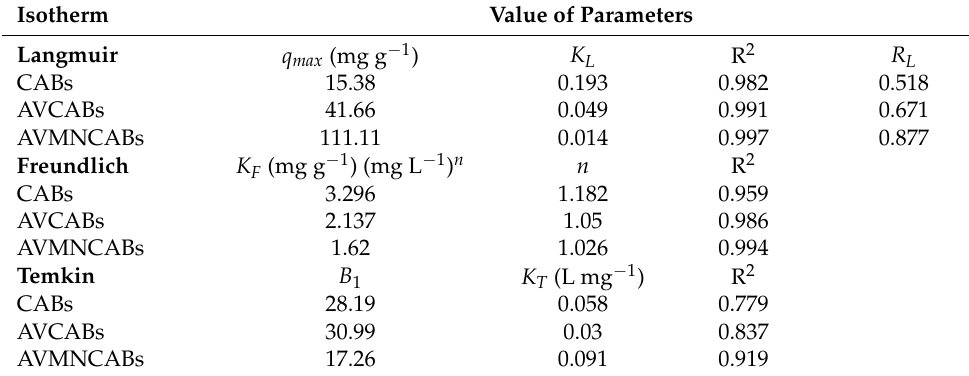
Table 2. Parameters of the adsorption isotherm of Cu(II) on various adsorbents.